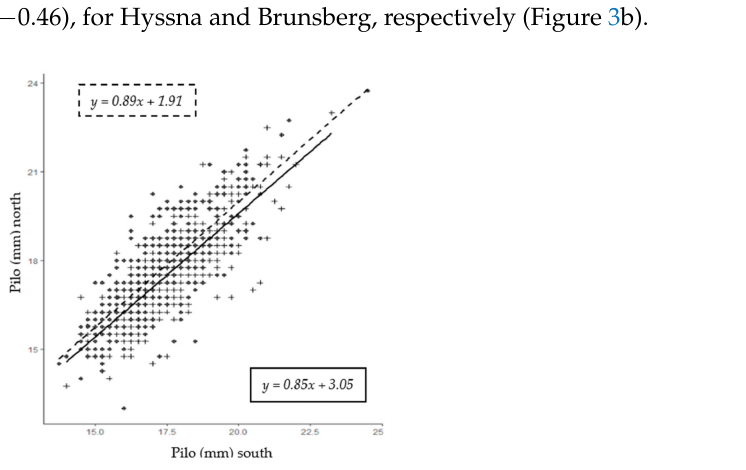
Figure 2. Plot comparing average north and south Pilodyn penetration at Hyssna (cross, solid line) and Brunsberg (circle, dashed line). Trend line equations are displayed for Hyssna (solid border) and Brunsberg (dashed